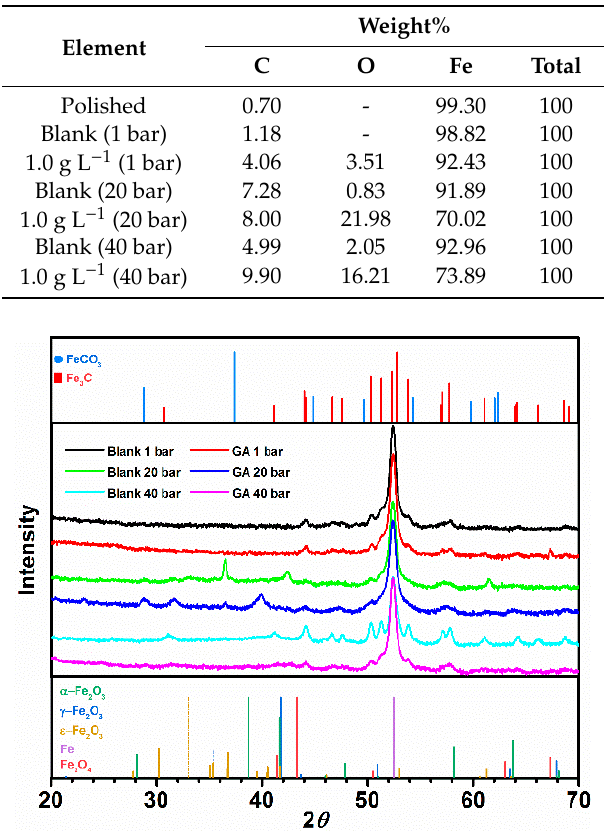
Figure 10. XRD spectra of corrosion product film formed on the metal surface after been exposed for 24 h without and with the presence of 1.0 g L − 1 of GA at different CO 2 partial pressures at 25 °C.